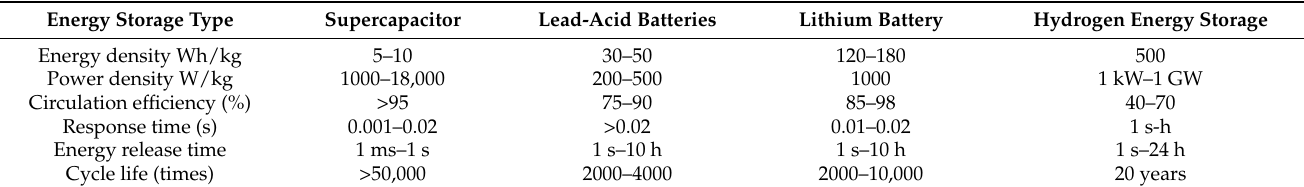
Table A2. Characteristics of Different Energy Storage